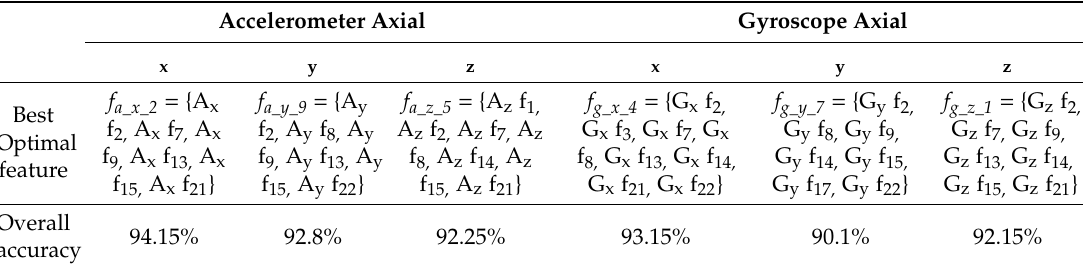
Table 3. Overall classification accuracy of final optimal features in wrapper approach in hybrid feature selection.